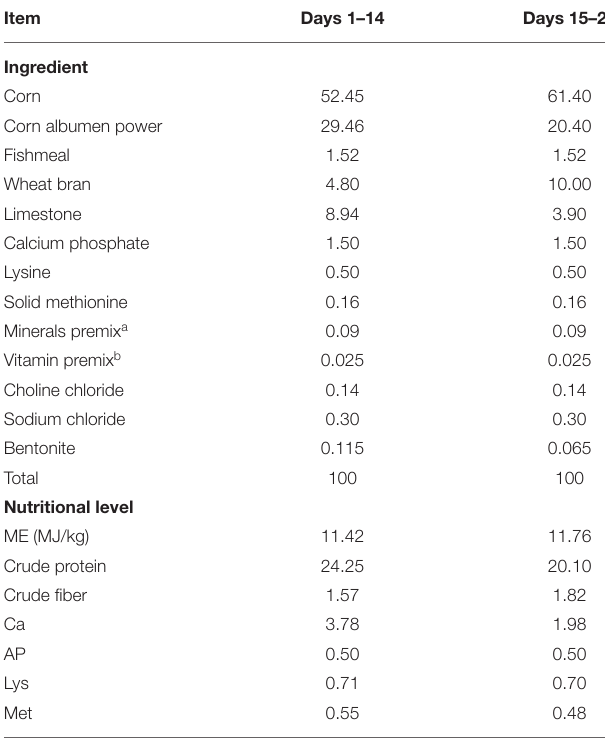
TABLE 1 | The compositions of basic diet and the nutritional level (air-dried basis,